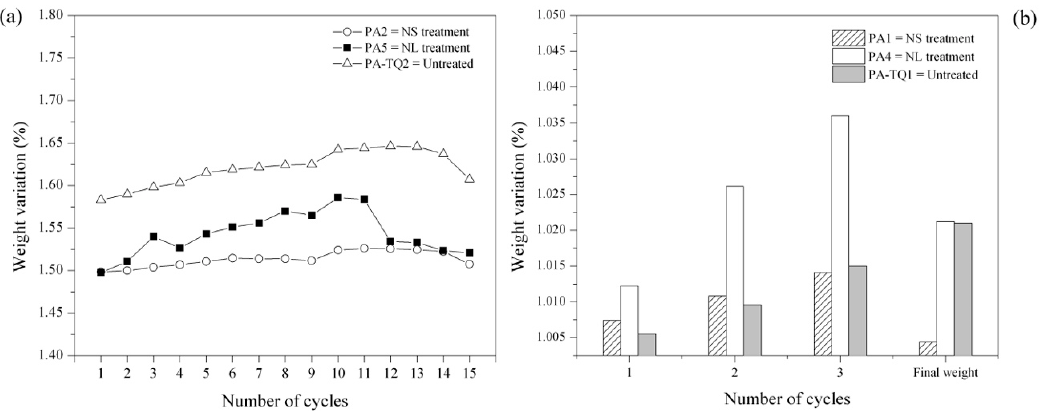
Figure 5. Weight variation (%) (a) after salt crystallization test and (b) after temperature/relative humidity jumps.